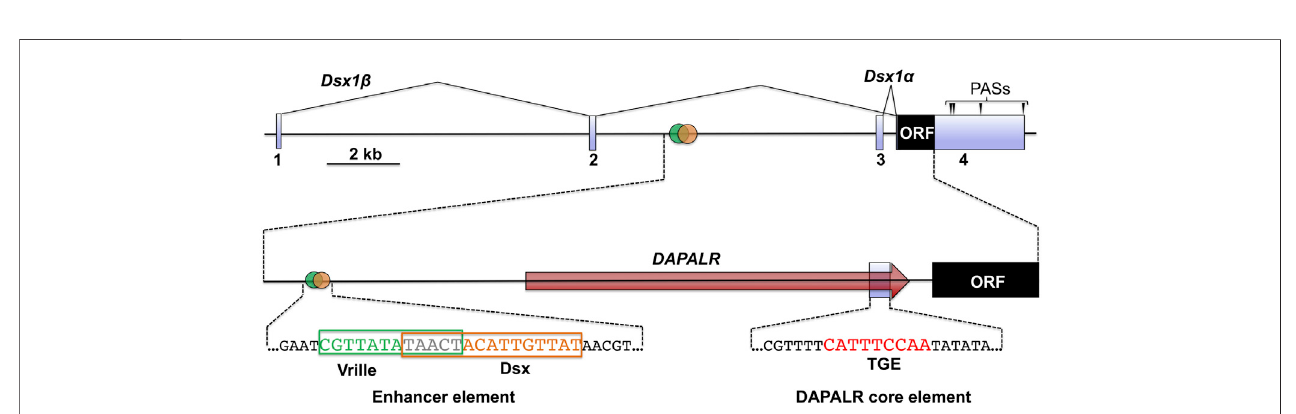
FIGURE 3 | Genomic structure of Dsx1 gene. Exons of Dsx1 are indicated with light blue boxes. The red arrow shows the region and direction of DAPALR . Polyadenylation sites are indicated with arrowheads. The enhancer element that includes the potential Vrille and Dsx binding sites is shown with its sequence. The position of the DAPALR core element is shown with the sequence that is similar to the TRA-2/GLI element (TGE). Adapted and modi fi ed from Kato et al. (2018).